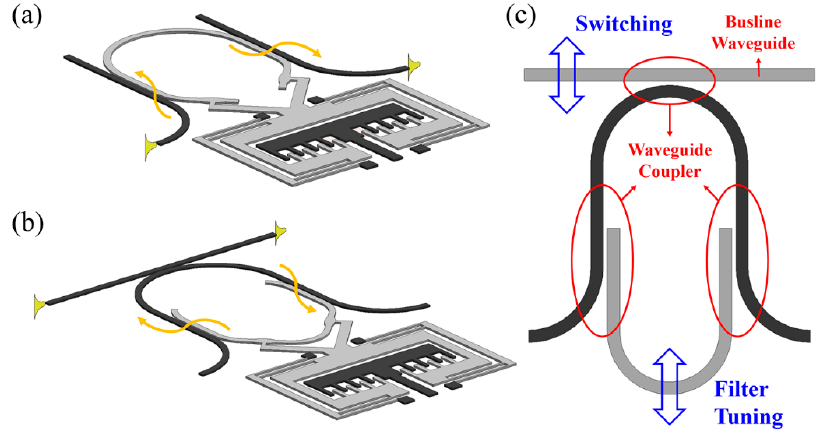
Figure 5. Schematic of ( a ) delay line (optical path length) tuning mechanism, ( b ) reconfigurable ring resonator consisting of two U-shaped waveguides, and ( c ) tuning of a mixed configuration (top view). A combination of optical path length tuning and coupling strength tuning is also possible